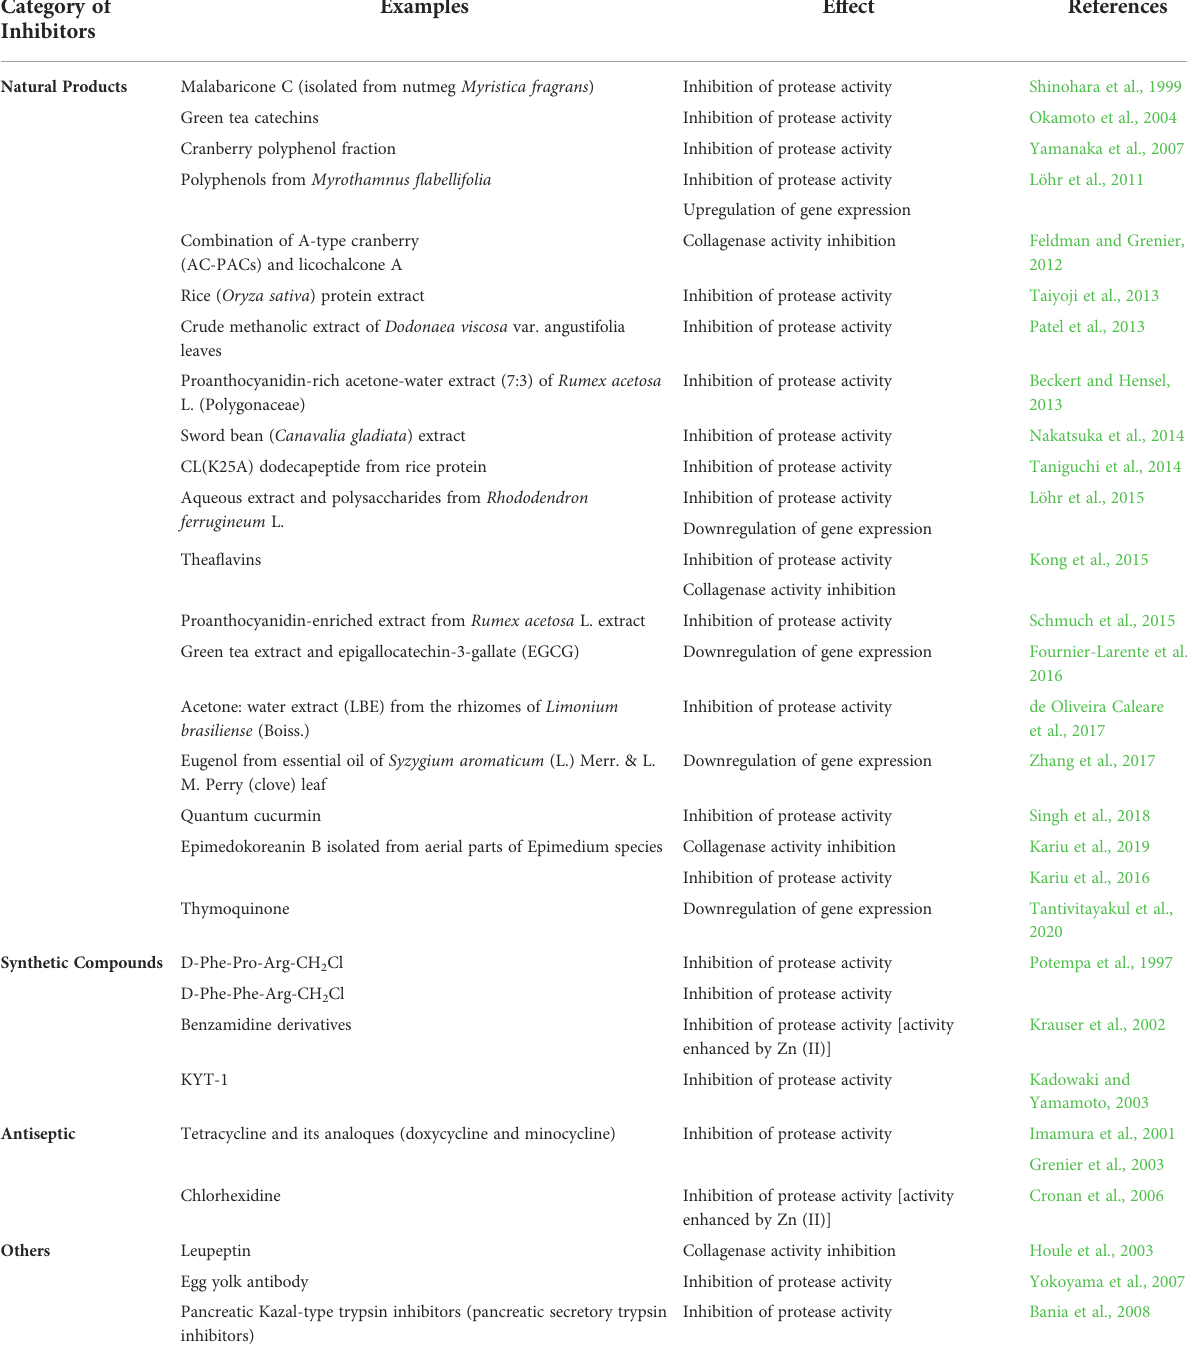
TABLE 3 In vitro inhibition of Rgp by natural and synthetic compounds as well as other